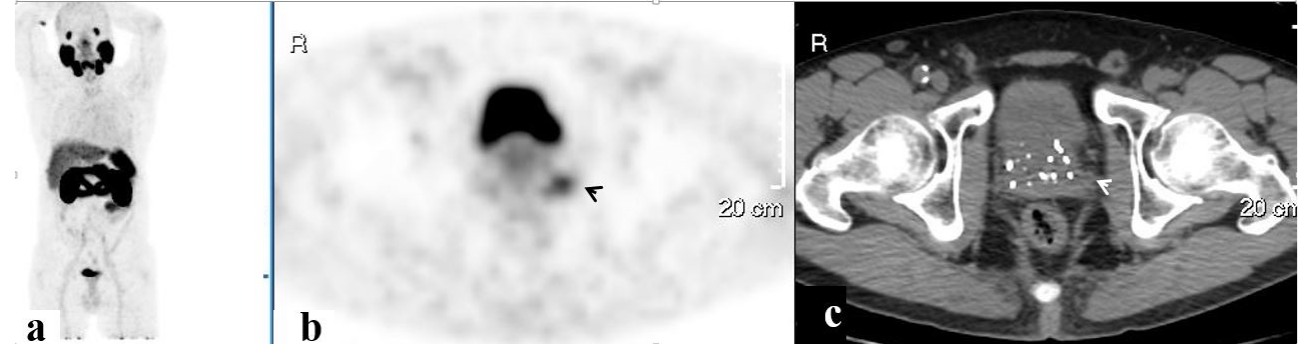
Figure 3. A PSMA-avid lesion in the prostate. 68Ga-PSMA scan, maximum intensity projection (MIP) ( a ) and corresponding PET ( b ) and CT ( c ) axial slices demonstrating focally increased uptake in the prostate on the left (arrows).